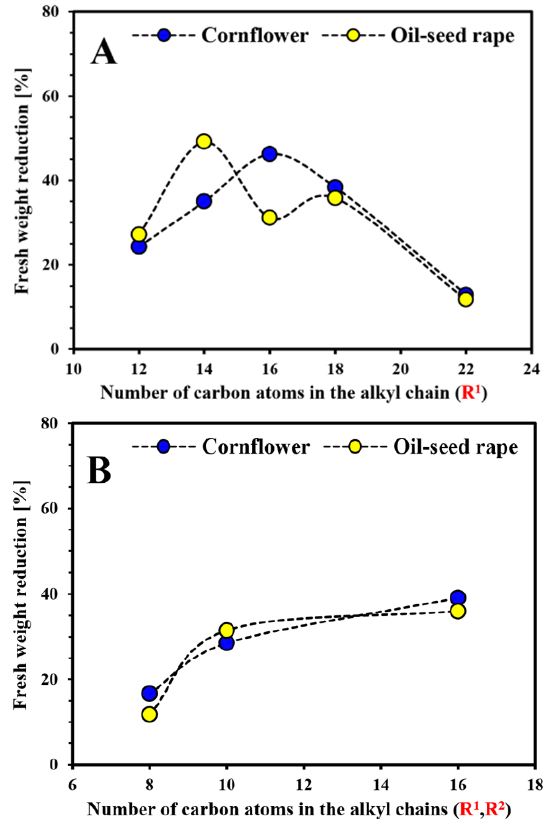
Figure 6. Influence of the alkyl chain length of the obtained HILs 1 – 5 ( A ) and 6 – 8 ( B ) on the effectiveness of fresh weight reduction of weeds. R 1 , R 2 —long alkyl chain.